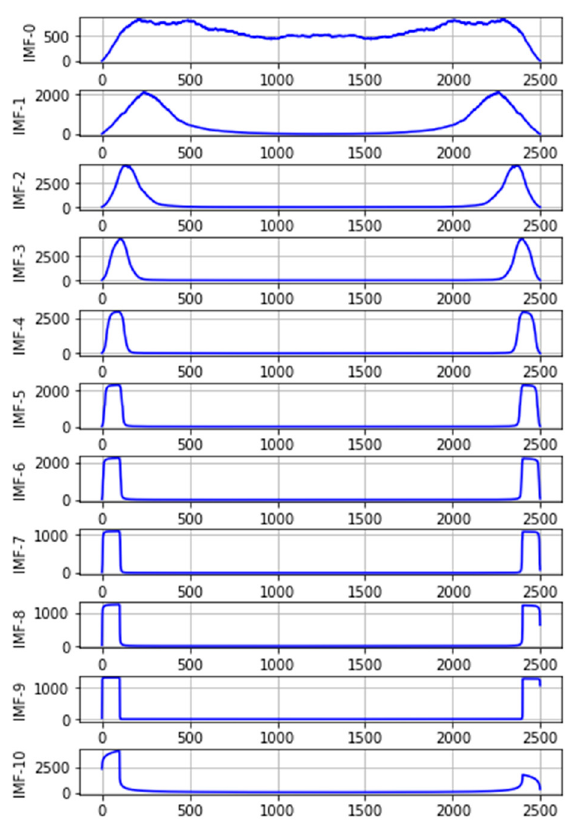
Figure 2. Convolution results for each IMF in the frequency domain. Mathematics 2020 , 8 , x FOR PEER REVIEW